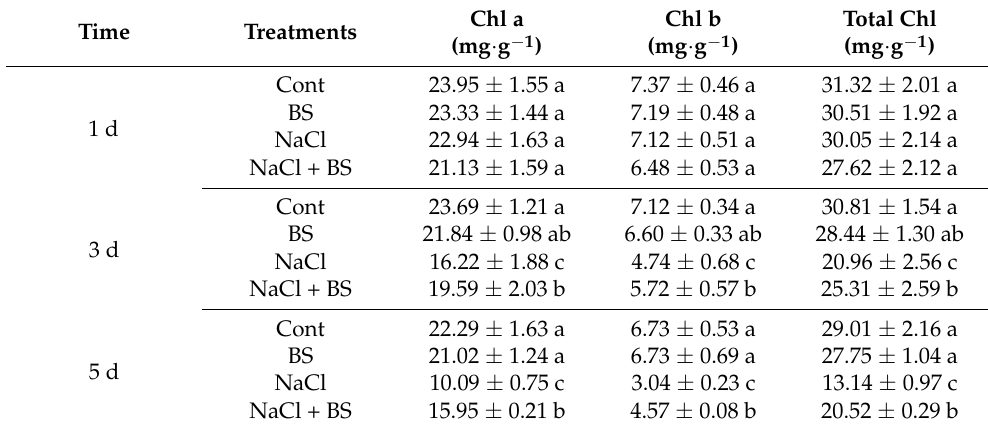
Table 1. Effect of B. cereus on the chlorophyll content of cucumber seedlings under salt stress. Different letters indicate a significant difference in the same parameter between treatments at p <